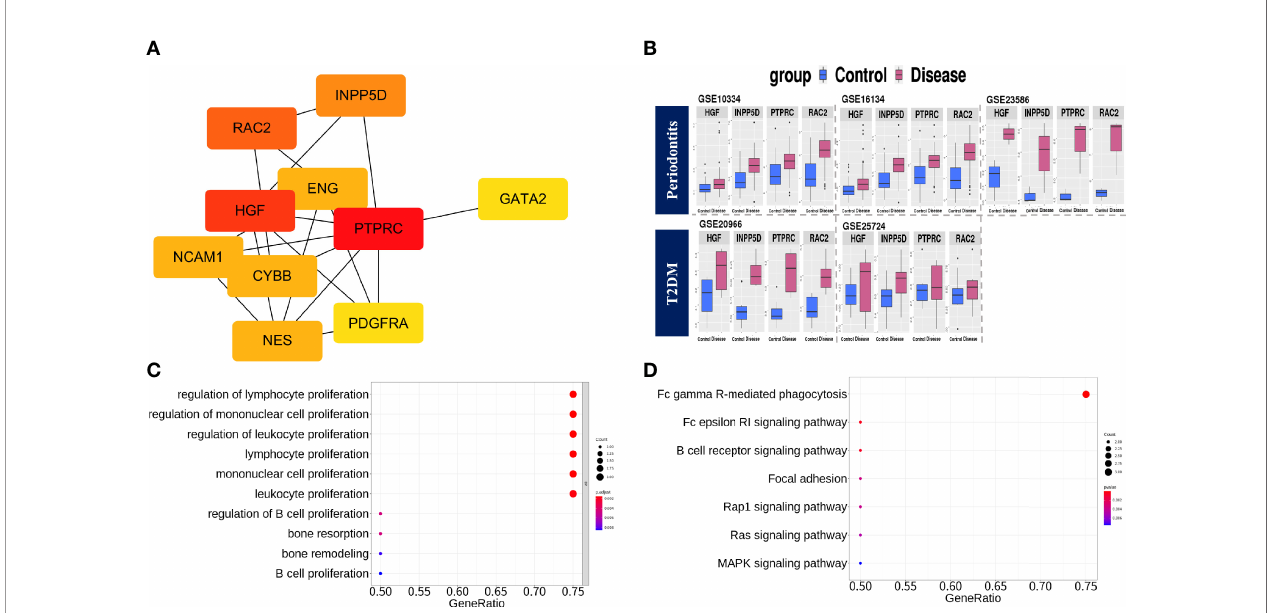
Figure 3D . GSE25724 dataset, and their AUC values Figure 4 . In periodontitis patients with diabetes samples, and